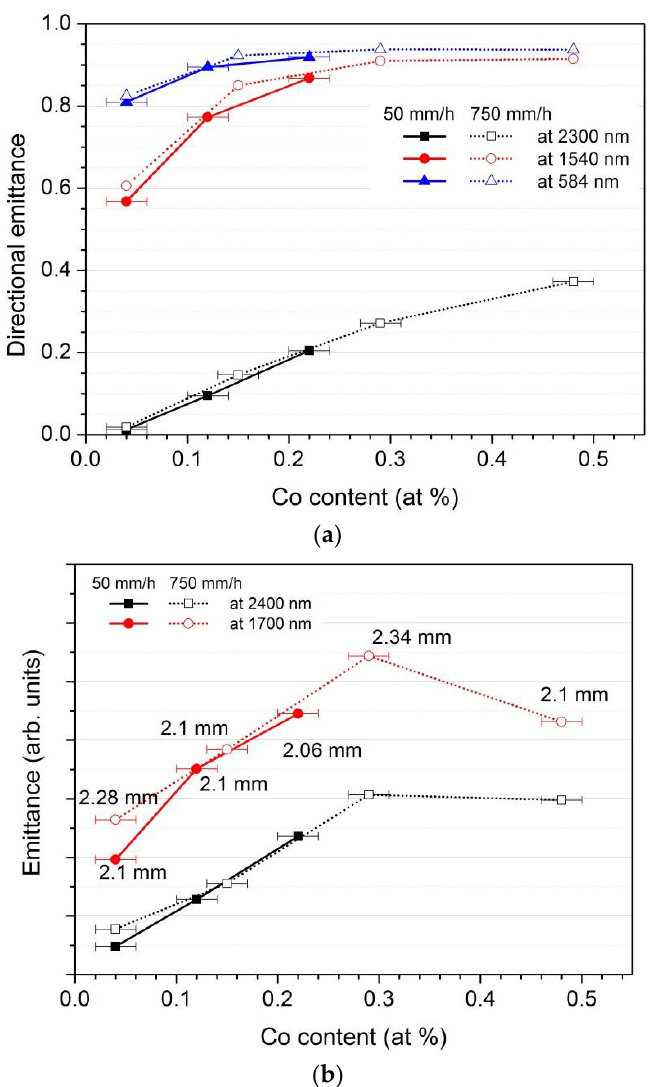
Figure 10. ( a ) Directional emittance at RT and ( b ) emittance at 1300 °C (calculated as thermal emis- sion intensity divided by black body Planck profile) at selected wavelengths as a function of the total Co content (at %) in the sample. The diameter on which the actual data were measured is writ- ten on the plot. the